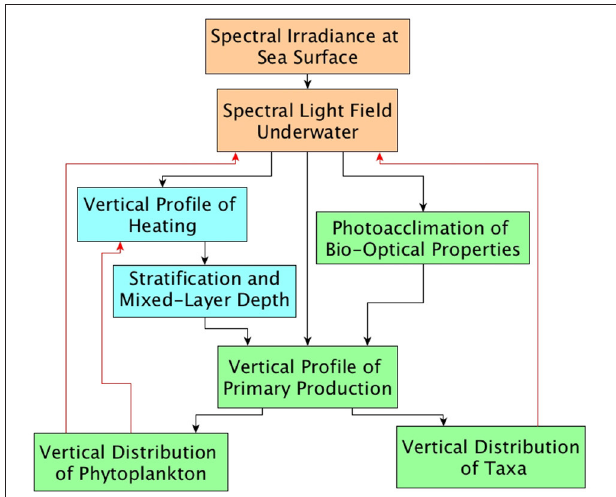
FIGURE 6 | Schematic showing principal factors affecting spectral irradiance field under water, and consequences for watercolumn production. The underwater light field is the resultant of a complex and reciprocal interplay between physics and